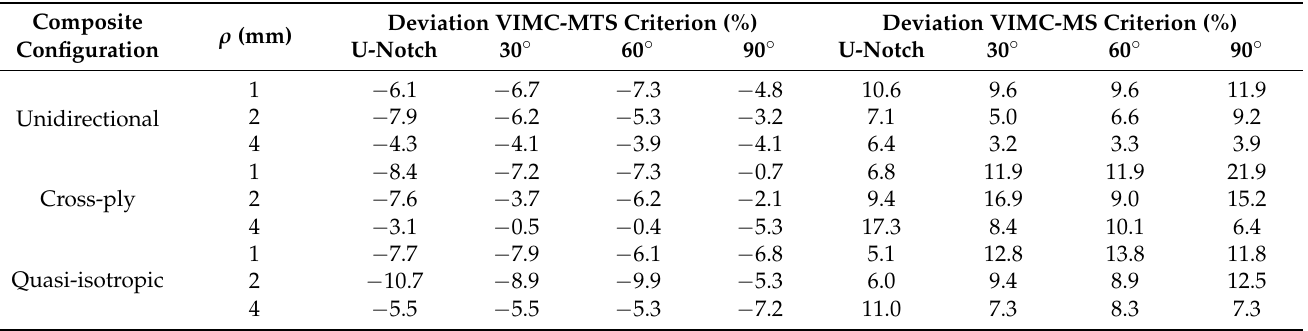
Table 5. Deviations between experimental and theoretical results for the different composite configu- rations and sample